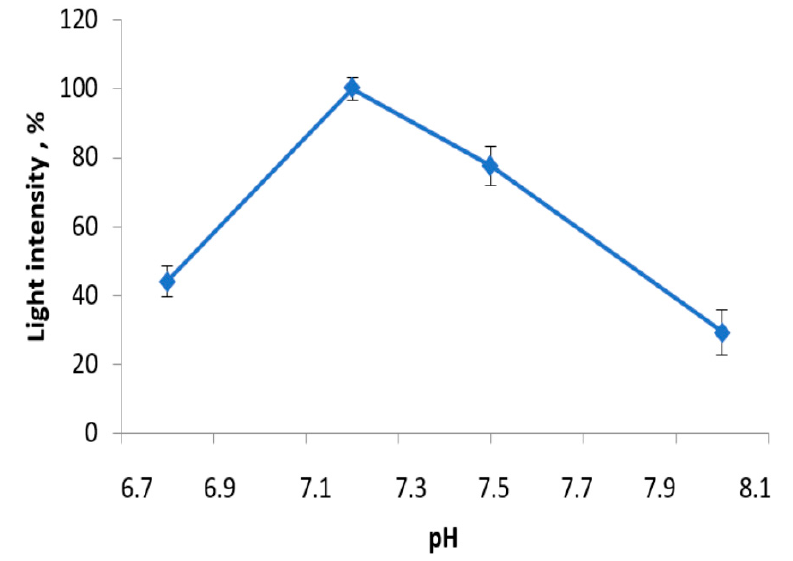
Figure 6. Activity of the LDH + Red + Luc enzyme system at different pH values.